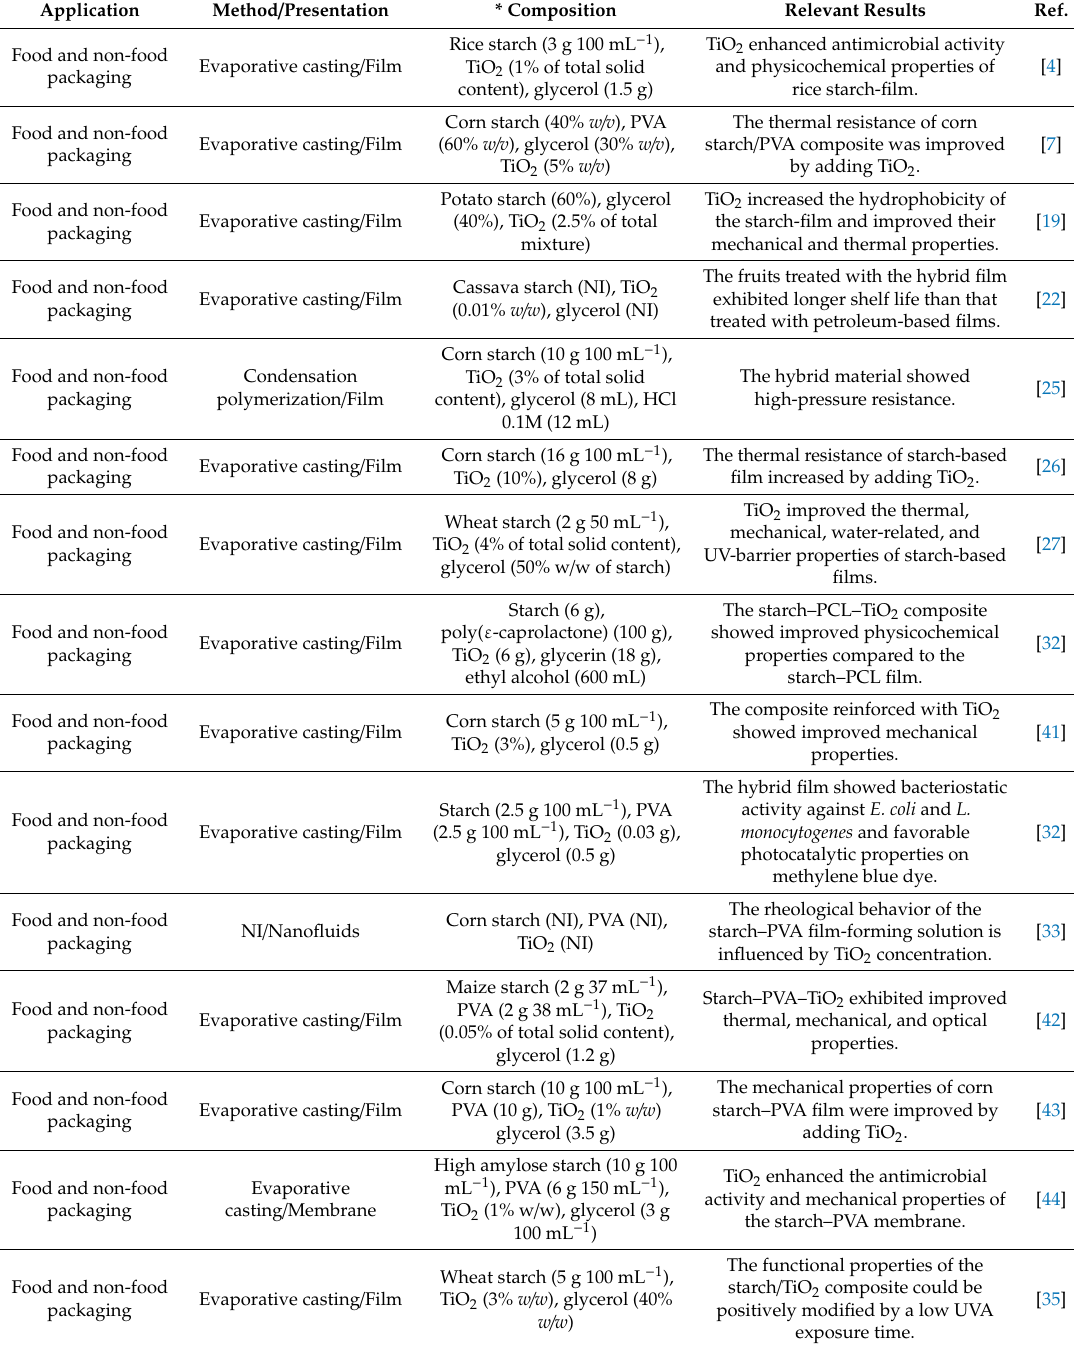
Table 1. E ff ect of TiO 2 incorporation on starch matrix